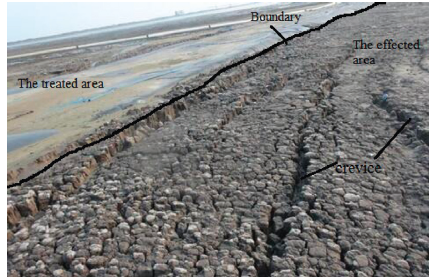
Figure 1: Deformation of the soil under vacuum consolidation.